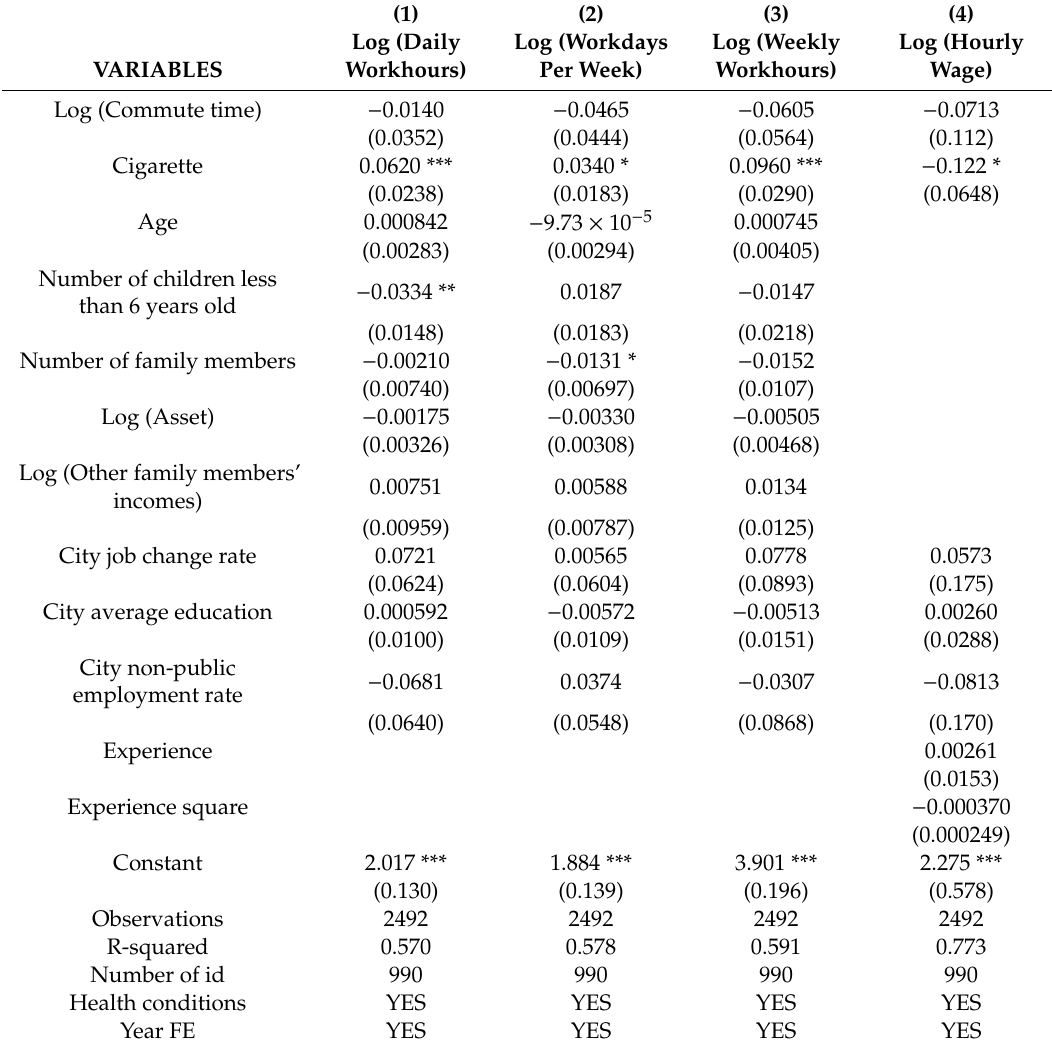
Table 8. Labor supply and wage for job unchanged